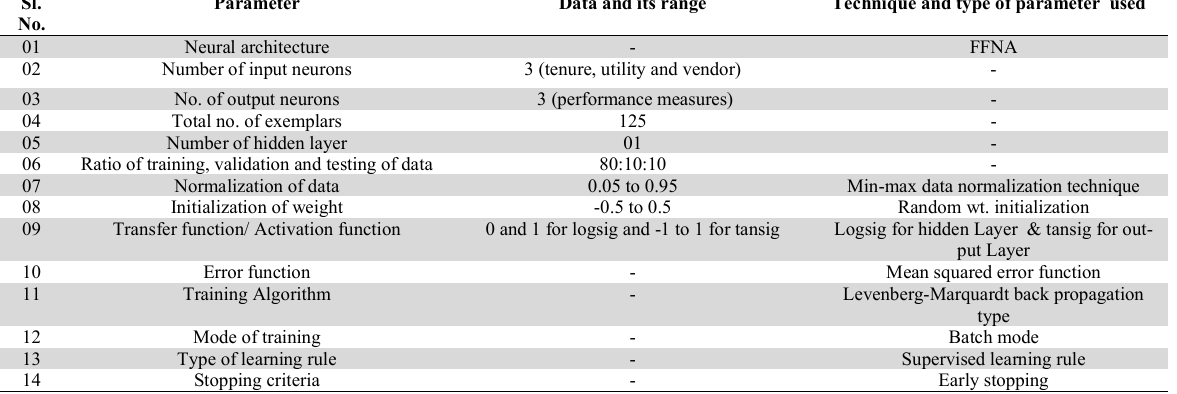
Optimal process parameter setting of Feed Forward Neural Architecture (FFNA) Sl.